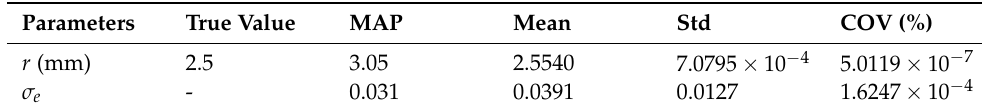
Table 4. Identified results from the ultrasonic experiments.